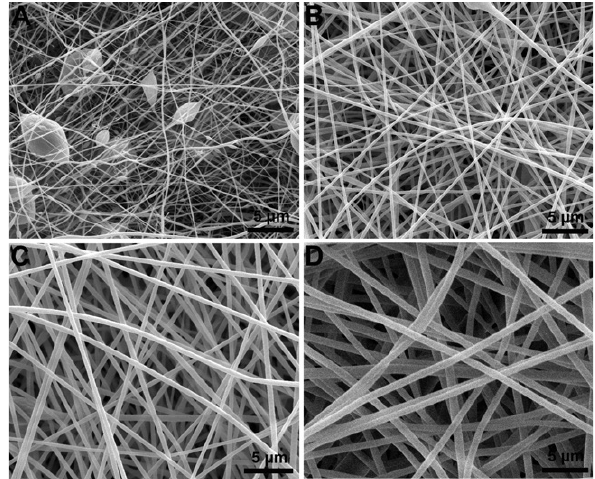
Figure 3: SEM images of nanofiber membranes with different con- centrations; A) 8wt%; B) 10wt%; C) 12wt%; D)